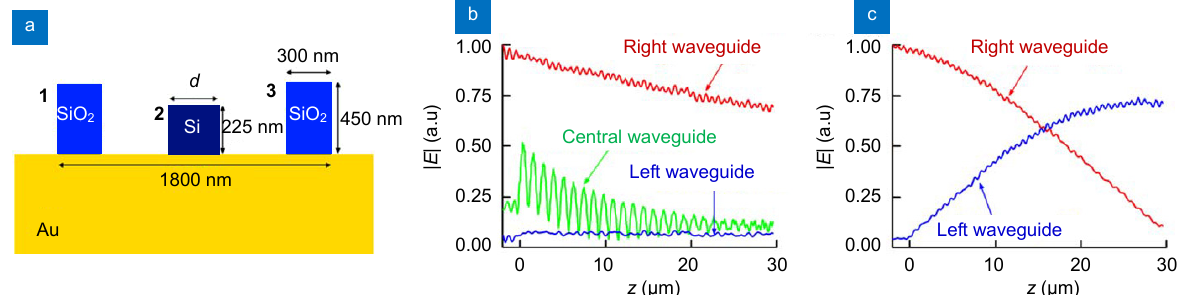
Fig. 6 | ( a ) The schematics of the surface plasmon waveguide system with the auxiliary waveguide. The distribution of the absolute values of the electric fields at waveguides ( b ) with and ( c ) without the auxiliary waveguide 33